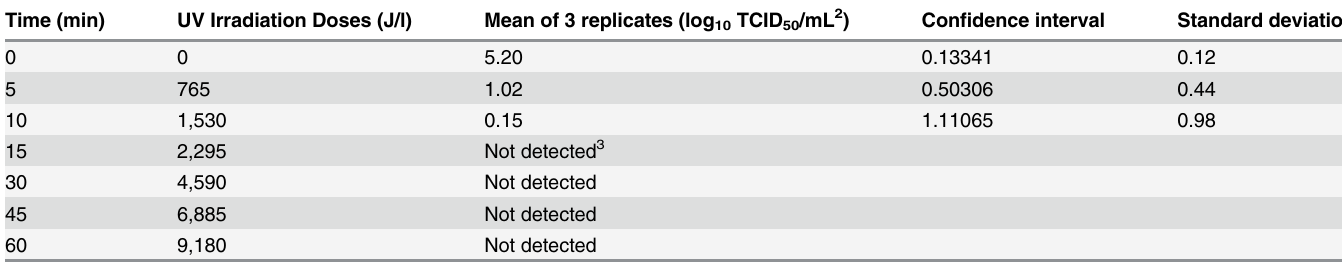
Table 4. Average Porcine Parvovirus (PPV) titres in inoculated bovine plasma used in Experiment 1 at each irradiation time (log10 values) 1 . Time (min) UV Irradiation Doses